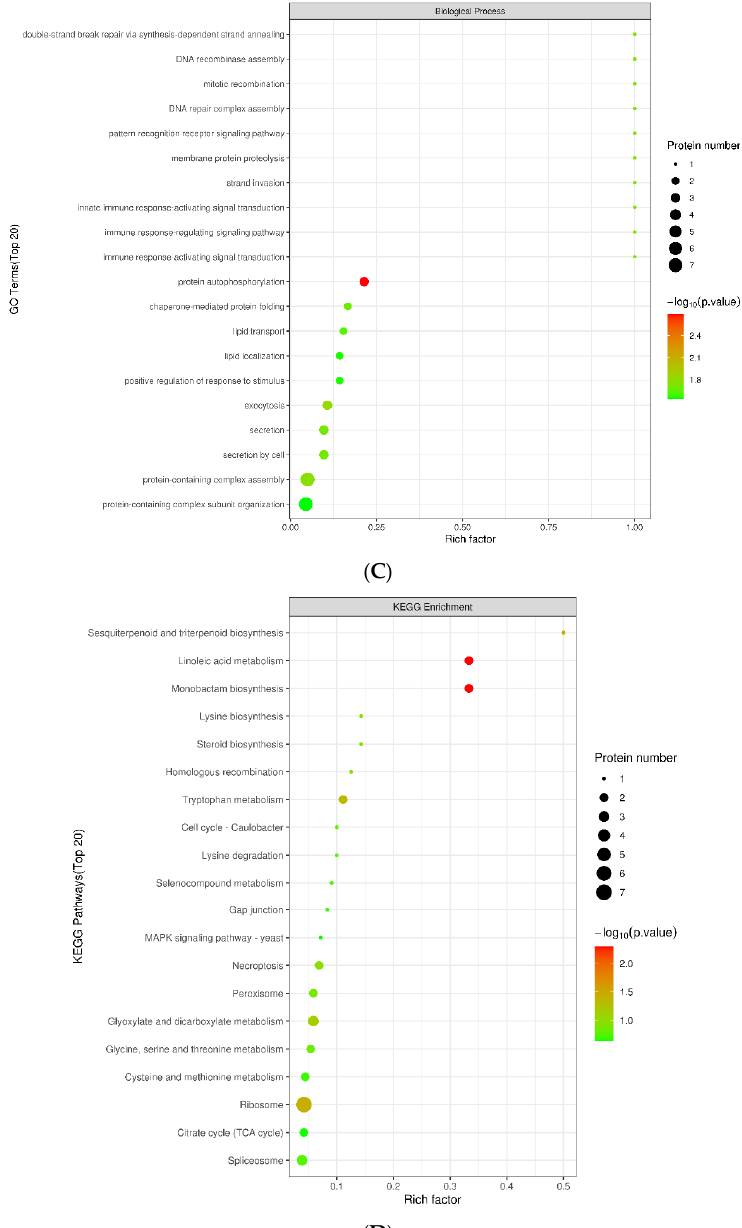
Figure 2. Expression profilling and enrichment of U. hordei responsive proteome. ( A ) expression heatmap of differently expressed proteins. The relative expression level of proteins is indicated by color. C: control, T: treat. Hypergeometric tests were performed based on the domain, GO, and KEGG annotation results of DEPs. ( B ) Domain enrichment of DEPs, ( C ) GO enrichment of DEPs in the biological process, ( D ) KEGG enrichment of DEPs. Abscissa is a rich factor which is defined as the ratio of DEP number, and the number of genes has been annotated in this pathway; point size represents DEP number; p ‐ value, shown by color from green to red.